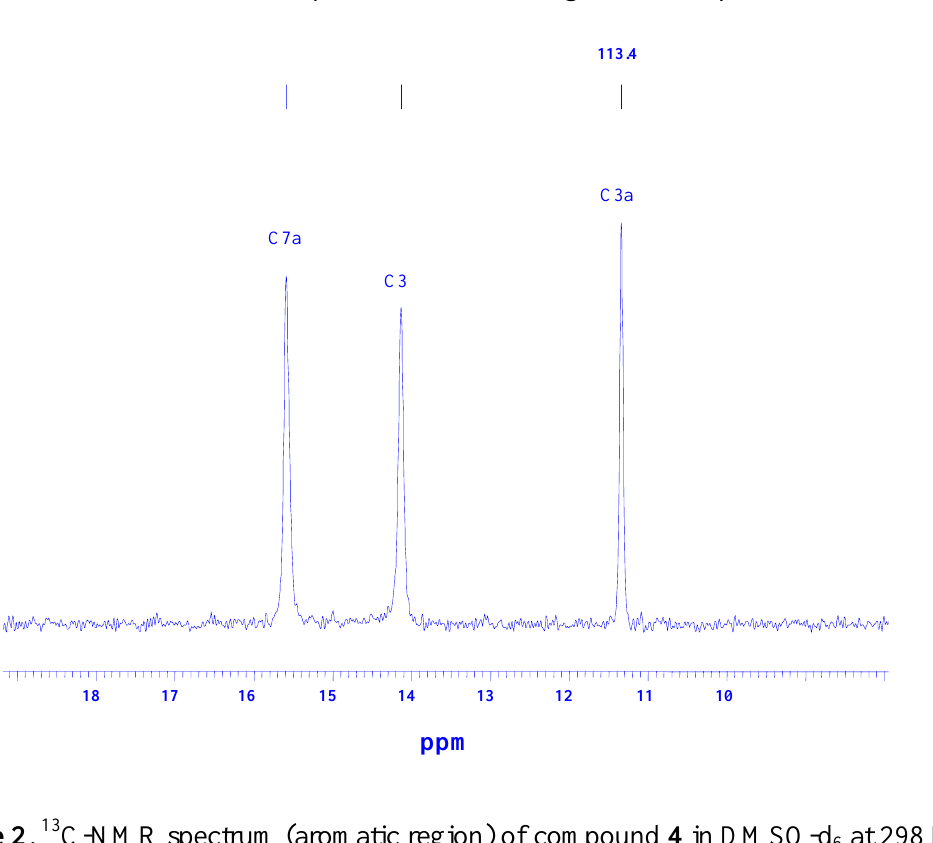
Figure 1. 13 C CPMAS NMR spectrum (aromatic region) of compound 4 at 298 K .